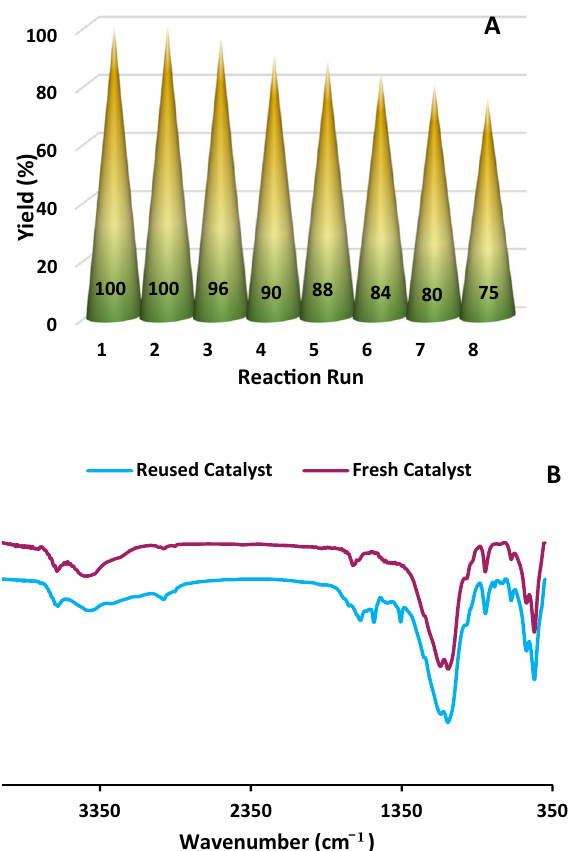
Figure 8. ( A ) The recyclability of the Bent-Gu-CD and ( B ) FTIR spectrum of the recycled catalyst after eight runs in synthesis of octahydroquinazolinones under optimum reaction